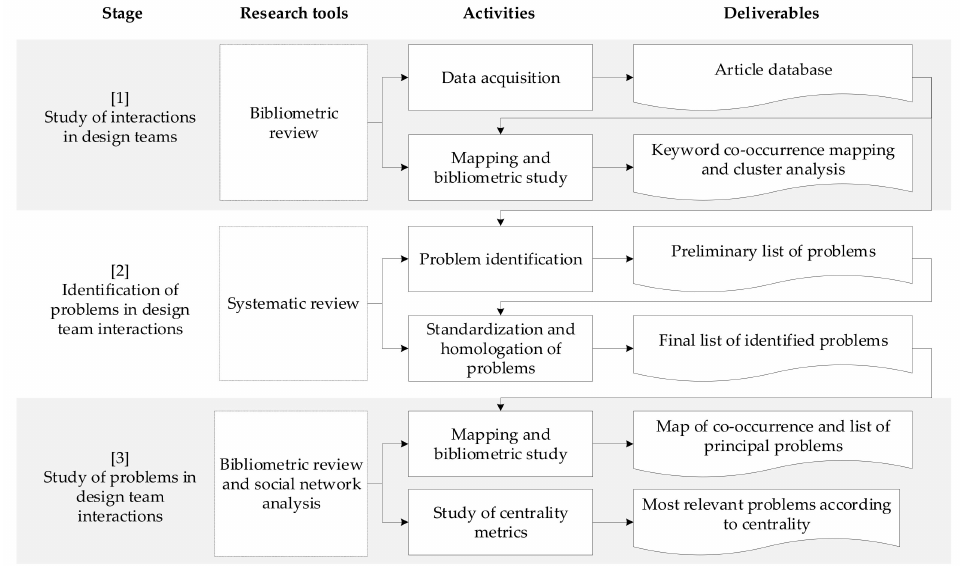
Figure 1. Research